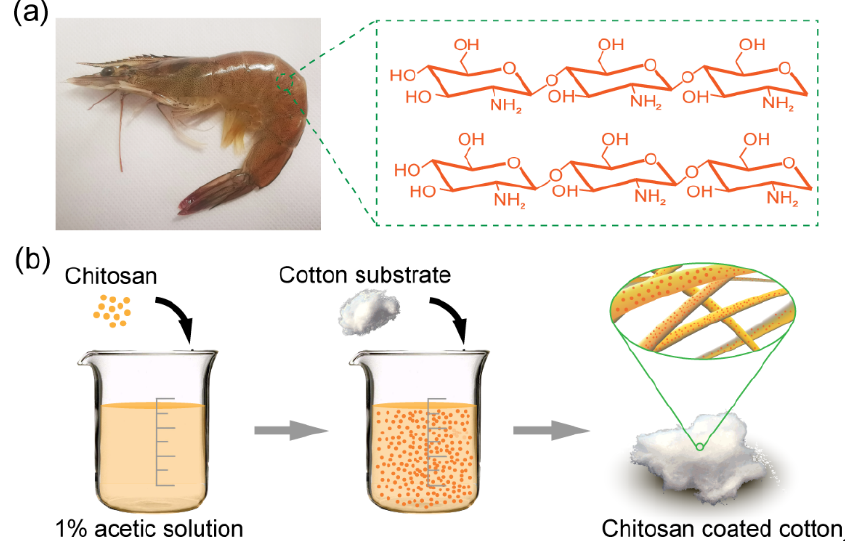
Figure 1. ( a ) The optical image of the shrimp and the chemical structure of the chitosan. ( b ) The fabrication process of the CTS-coated cotton.